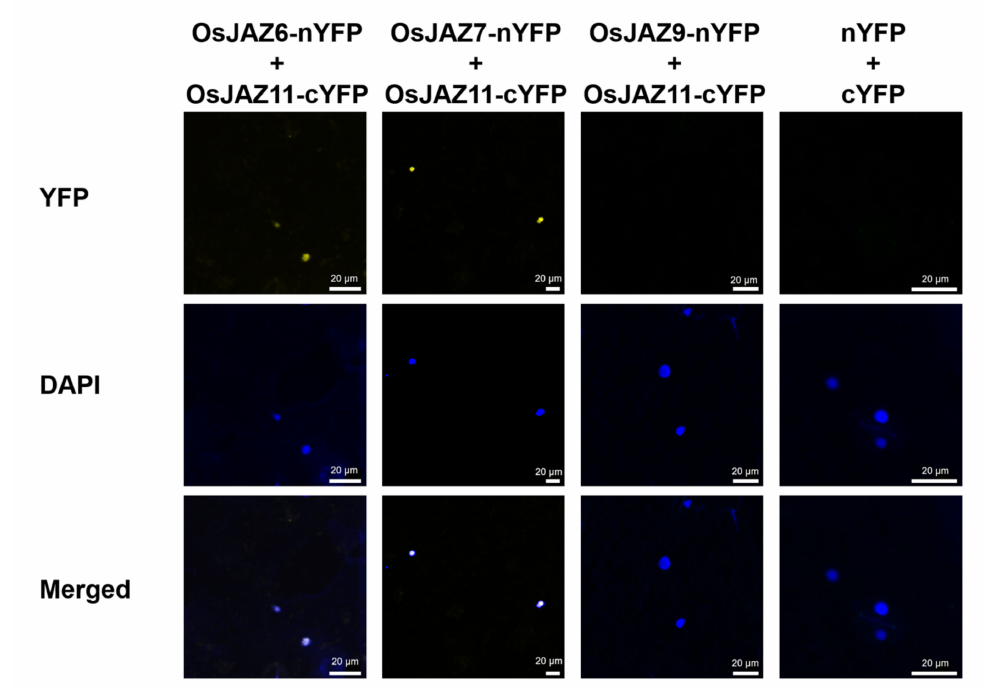
Figure 5. Heteromeric interaction of rice JAZ proteins. BiFC assay of heteromeric interactions in planta. YFP fluorescence was detected in Nicotiana benthamiana leaves coinfiltrated with Agrobacterium strains expressing OsJAZ6-nYFP, OsJAZ7-nYFP and OsJAZ11-cYFP. DAPI staining showed the location of the nuclei. The merged image shows the colocalization of DAPI and YFP fluorescence.